Question: Write a caption explaining this figure to a reader.
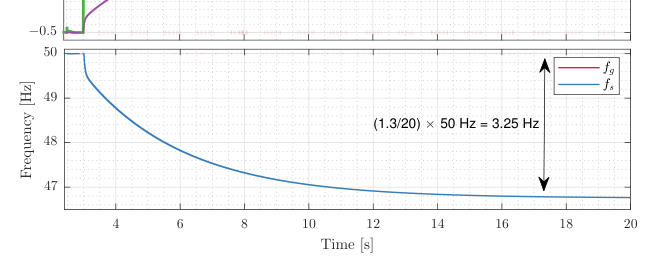
Answer: Main grid disconnection scenario — Top: Active powers in [p.u.] with Sbase; Bottom: ac frequency in [Hz].